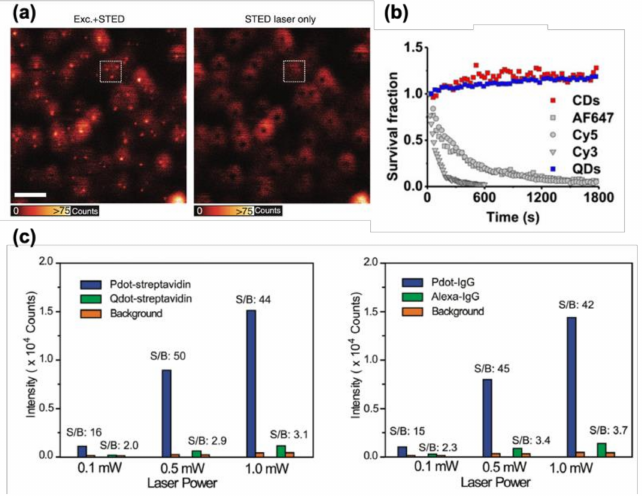
Figure 6. ( a ) Left: Qdot705 imaged with STED nanoscopy, i.e., with both the STED and the excitation beam. Right: The same sample imaged only with the doughnut-shaped STED beam. ( b ) Survival frac- tion during continuous STED illumination compared for different types of fluorescence probes. ( c ) Left: Average fluorescence brightness and SNR of Pdot − streptavidin and Qdot − streptavidin. Right: Aver- age fluorescence brightness and SNR of Pdot − IgG and Alexa 488 − IgG. ( a ) Reprinted (adapted) with permission from [27]. Creative Commons Attribution 4.0 International License. ( b ) Reprinted (adapted) with permission from [106]. Copyright 2021 American Chemical Society. ( c ) Reprinted (adapted) with permission from [111]. Copyright 2021 American Chemical